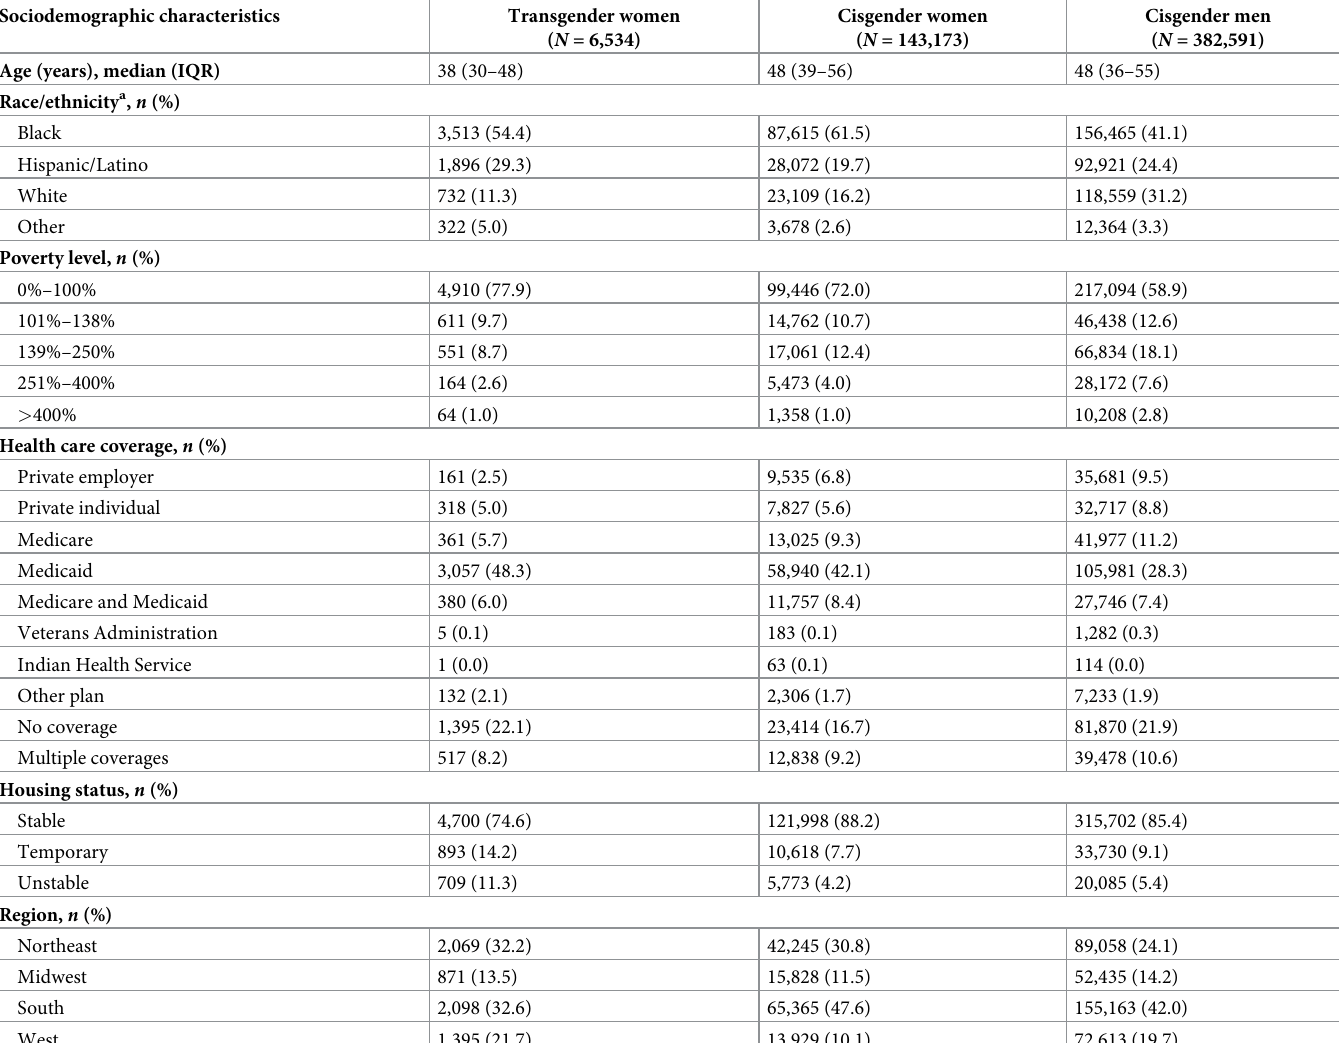
Table 1. Transgender women, cisgender women, and cisgender men served by the HRSA RWHAP, 2016. Sociodemographic